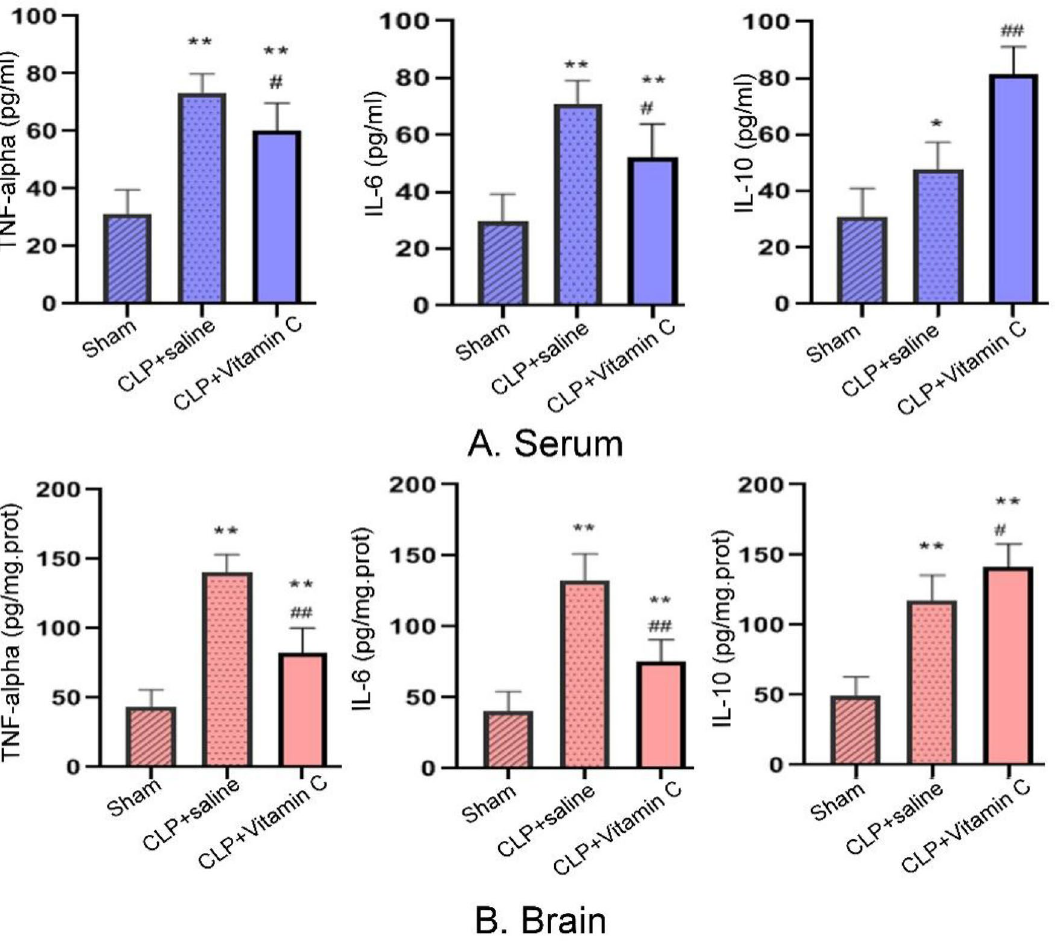
Figure 3. Comparison of TNF-α, IL-6 and IL-10 levels in the serum ( A ) and brain hippocampus ( B ) of rats in three groups 24 h after operation. Compared with the sham group, the levels of inflammatory cytokines of TNF- α, IL-6, and IL-10 in the serum and hippocampus in both the CLP + saline group and CLP + vitamin C group were significantly increased (P = 0.000). Compared with the CLP + saline group, the levels of TNF-α and IL-6 in the serum and hippocampus in the CLP + vitamin C group were significantly decreased (P = 0.001). The anti- inflammatory cytokine (IL-10) in the serum and hippocampus were significantly increased (P = 0.001).* P < 0.05 and ** P < 0.01 compared with sham group; # P < 0.05 and ## P < 0.01 compared with CLP group. TNF-α tumor necrosis factor, IL-6 interleukin-6, IL-10 interleukin-10, CLP cecal ligation and